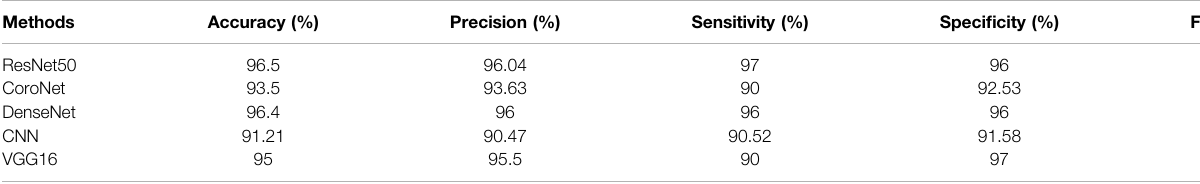
TABLE 4 | Evaluation metrics of different methods used in pneumonia classi fi cation. Methods